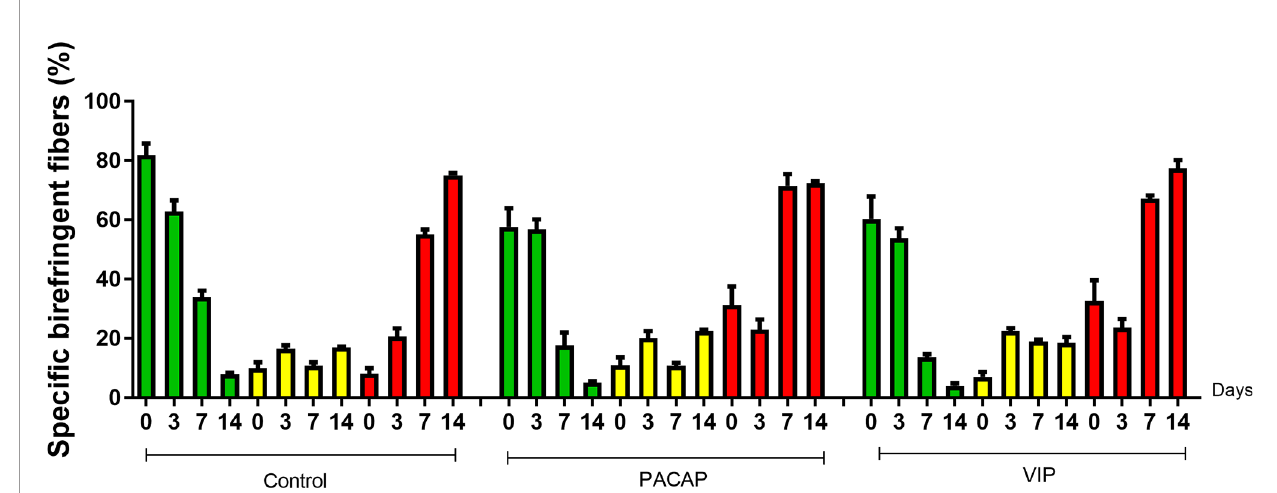
FIGURE 12 | Quantitative analysis of the area (pixels 2 ) occupied by green, yellow, and red birefringent collagen fi bers in the dental alveolus at 0, 3-, 7-, and 14-day post-exodontia periods, in the control and treated animals with PACAP and VIP. Periods of 0, 3, 7 and 14 days represented in relation to the area in pixels 2 of birefringent fi bers within the green, yellow and red spectrum percentage to the total area, throughout the experimental periods. The results represent the values of the mean and standard deviation in each of the periods analyzed.